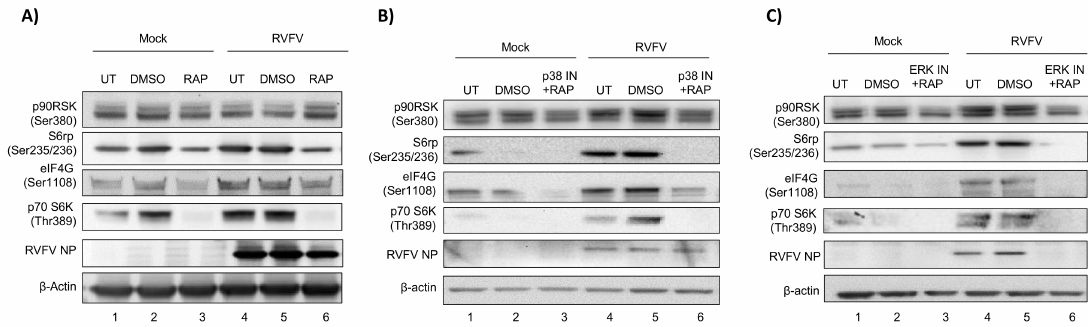
Figure 7. Rapamycin in combination with the p38 MAPK inhibitor SB203580 or the ERK inhibitor PD0325901 decreases translational signaling and RVFV NP production. H2.35 cells were serum starved for 72 h and then were pre-treated with either 10 µ M RAP ( A ), RAP + p38 IN ( B ), or RAP +ERK IN ( C ). Cells were infected with MP12 (MOI 5) for one hour, followed by removal of viral inoculum, and addition of growth medium containing the inhibitors. At 18 hpi, cell lysates were collected for western blot analysis. UT = untreated. Images are representative of biological